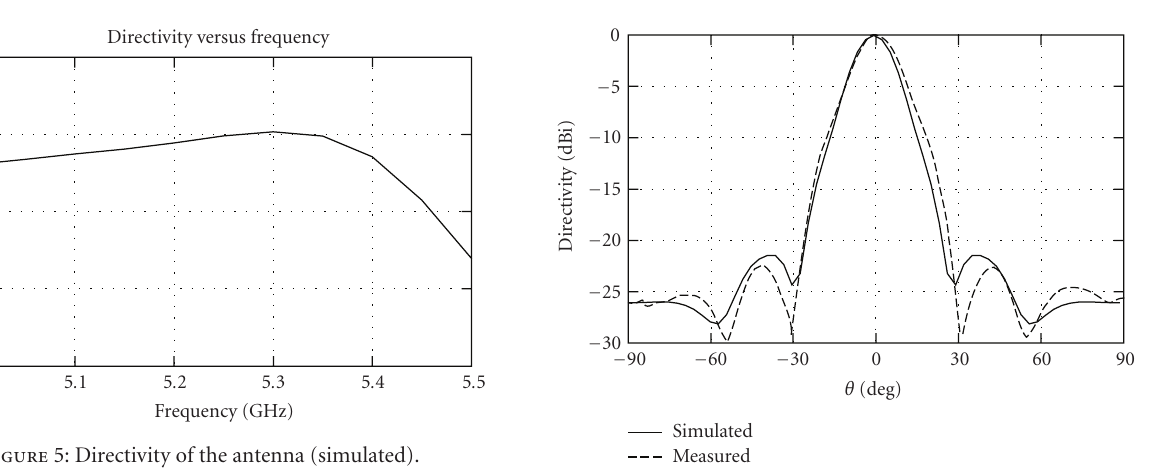
Figure 5: Directivity of the antenna (simulated).